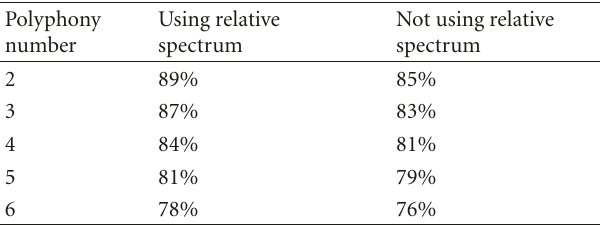
Table 5: Results of multiple fundamental frequency frame Level estimation task of MIREX